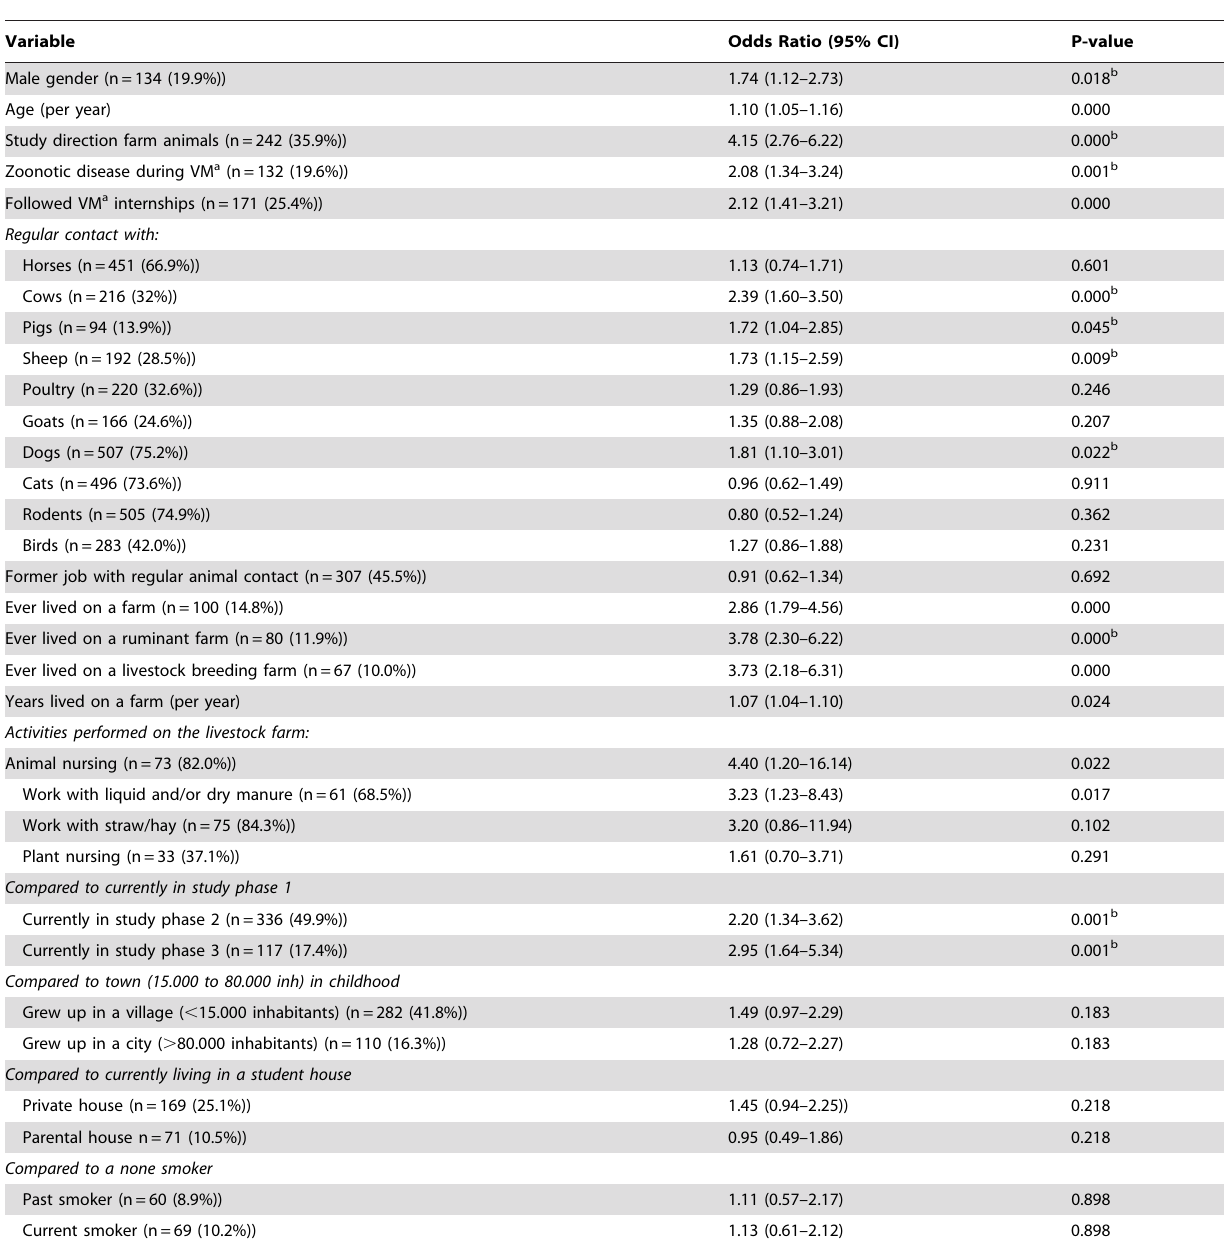
Table 4. Univariate analysis of factors possibly associated with seropositivity for Coxiella burnetii among veterinary medicine